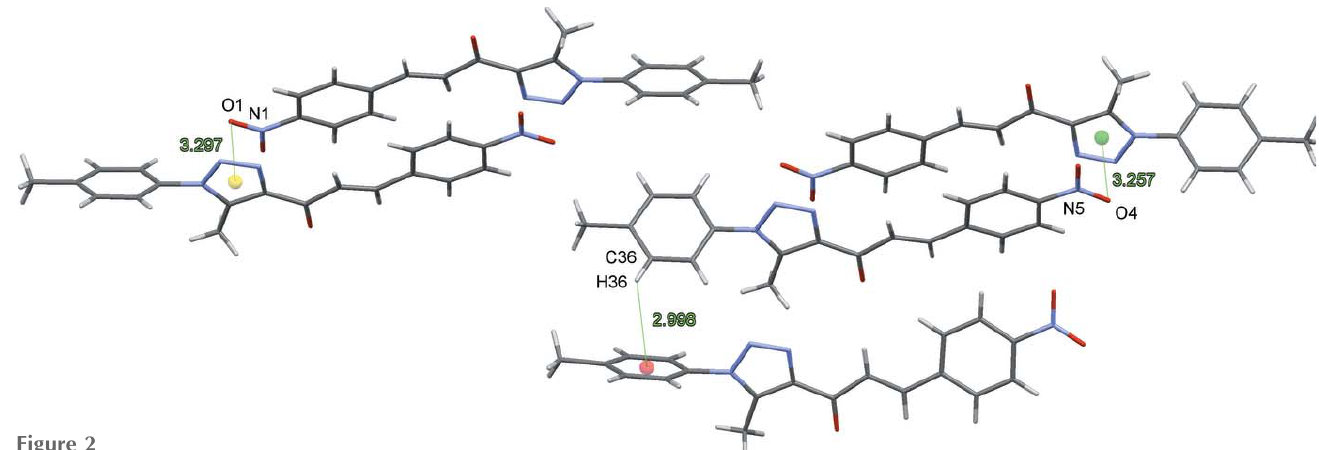
Figure 2 Detail of the packing showing short C—H (cid:3)(cid:3)(cid:3) (cid:2) and N—O (cid:3)(cid:3)(cid:3) (cid:2)